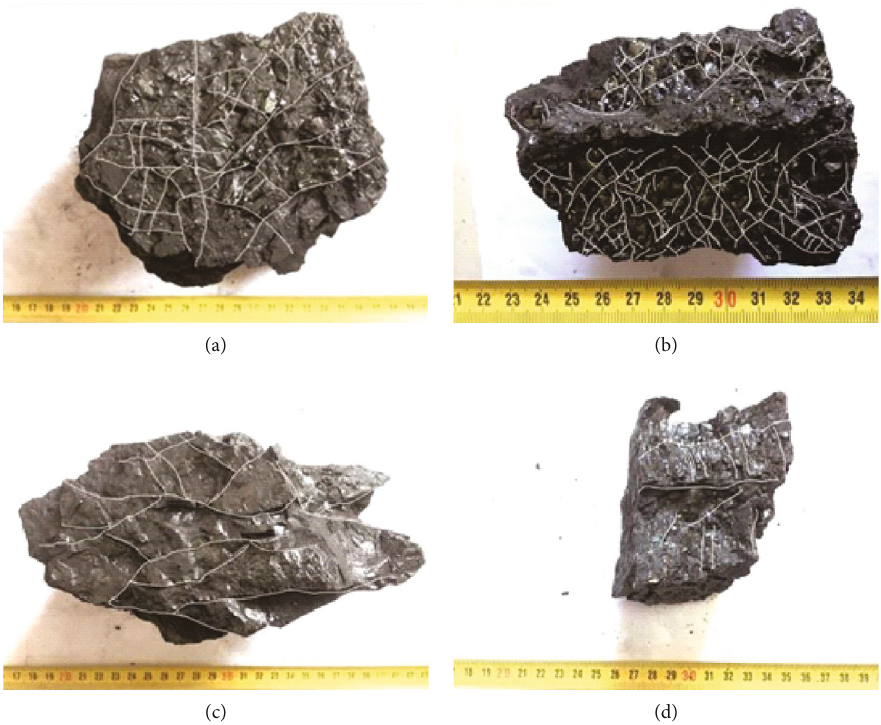
Figure 7: Endogenous fractures and their distribution in coal. (a, b) Interconnected endogenous fractures fi lled with minerals and (c, d) endogenous fractures without mineral fi